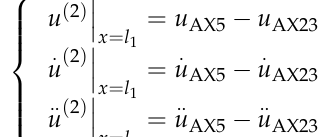
are calculated through Equation (34).